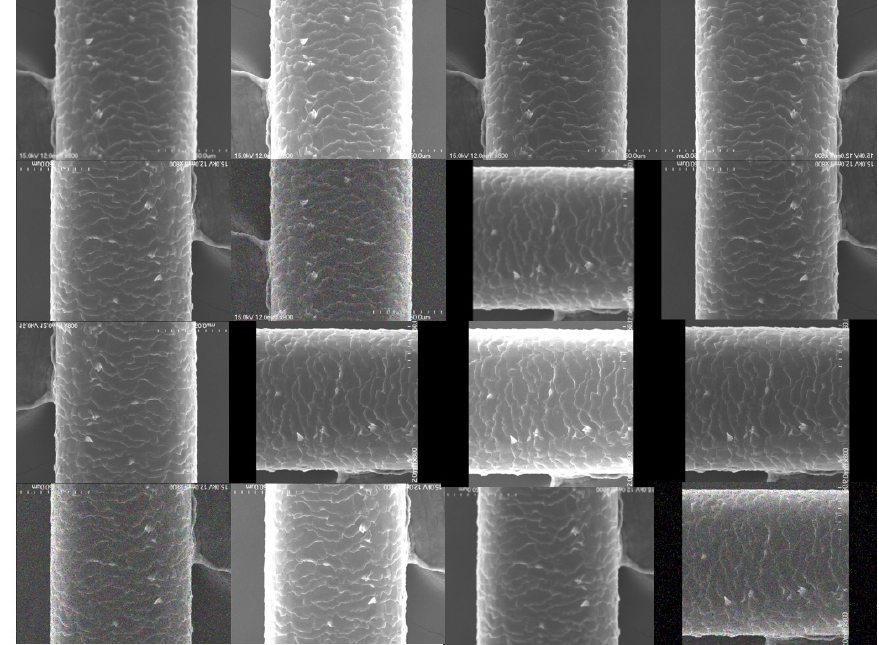
Figure 8. Hair SEM microscopic image data augmentation.